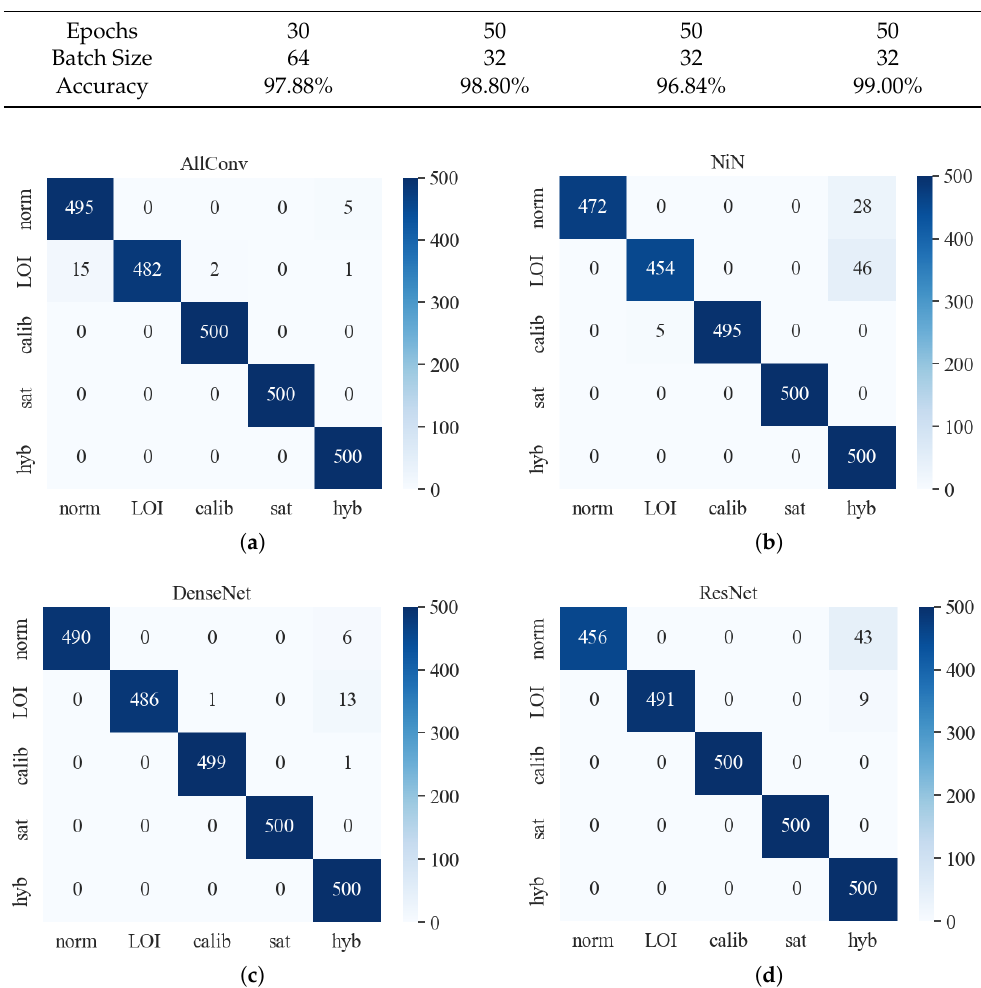
Figure 3. The confusion matrices of the four networks for CV-QKD attack detection. ( a ) The predicting results of AllConv model. ( b ) The predicting results of NiN model. ( c ) The predicting results of DenseNet model. ( d ) The predicting results of ResNet model. AllConv: all convolution network. NiN: Network in Network. Norm: the unattacked state. LOI: LO intensity attacks. Calib: calibration attacks. Sat: saturation attacks. Hyb: the hybrids